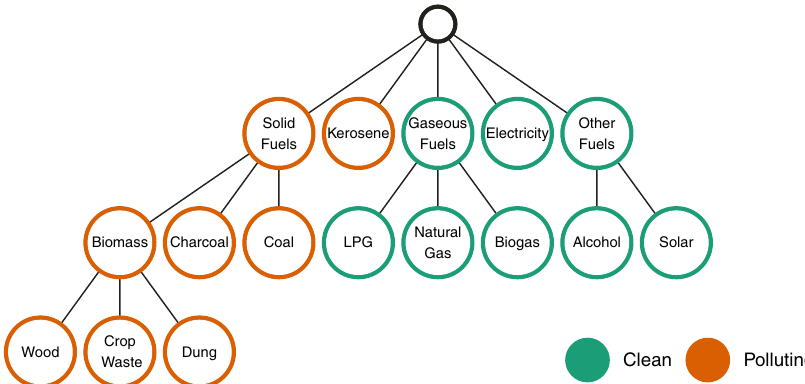
Fig. 1 Cooking fuel categorization. Classi fi cation of cooking fuels within the scope of the global household energy model as clean or